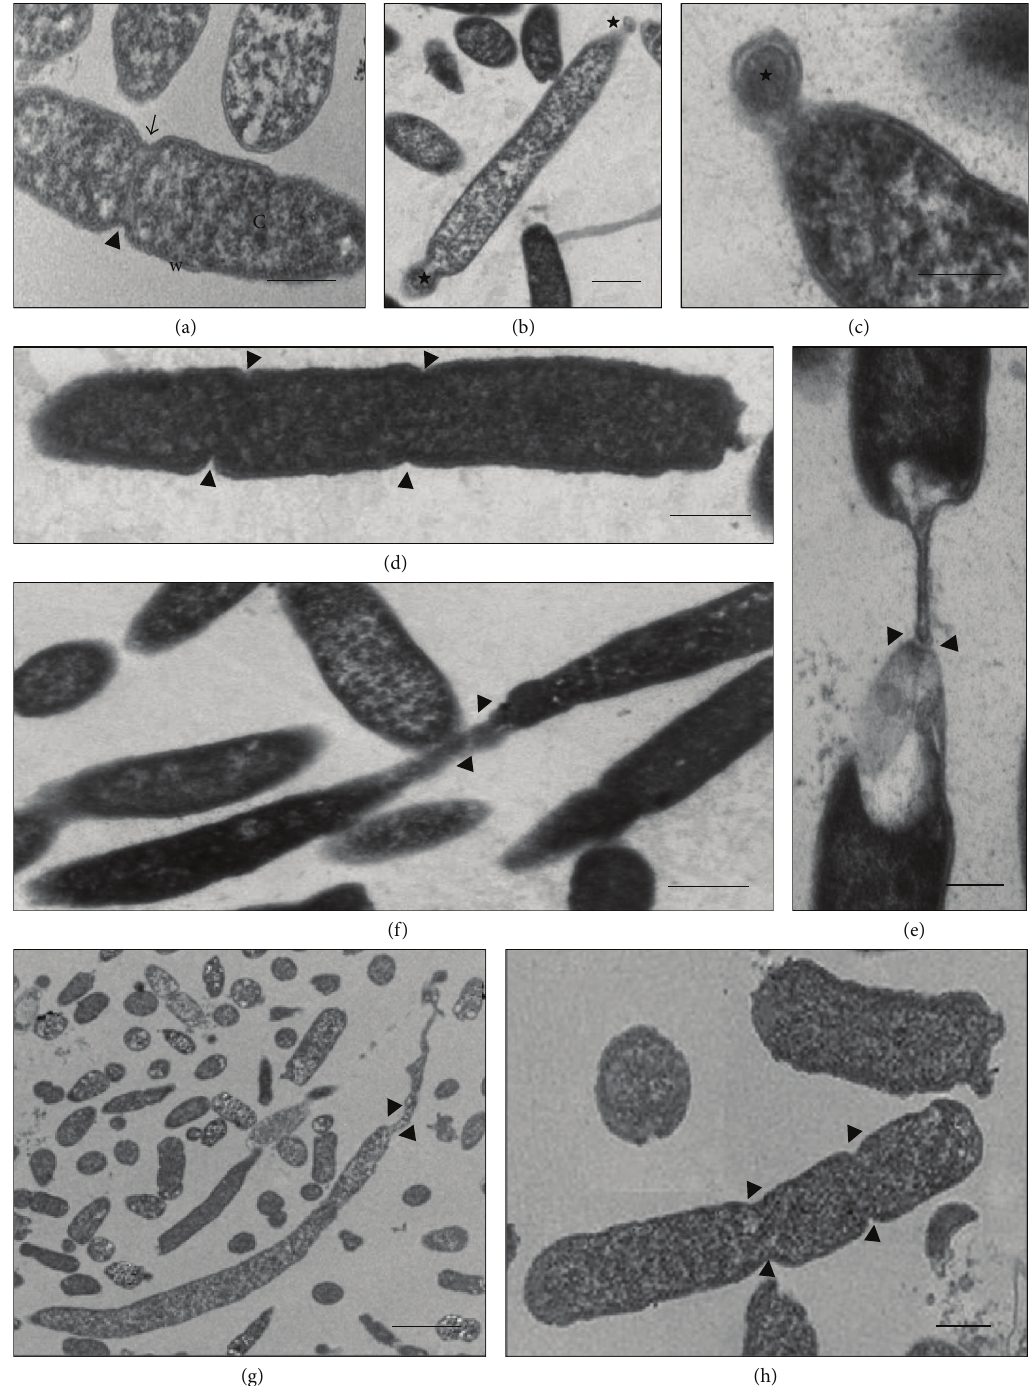
Figure 3: (a–h) Transmission electron micrographs of isolate K652 of K. pneumoniae . (a) Untreated bacterial cell—cell wall with preserved morphology (w) and cytoplasm (C) intact, besides regular septation (arrowheads). (b-c) Cell subjected to CTX (98 𝜇 gmL −1 )—presence of cells not grown and rounded (stars) at the ends of cells with normal morphology. (d–f) Cells subjected to CAZ (27 𝜇 gmL −1 )— consecutive formation of septa (arrowheads) providing elongation of bacterial morphology. Observe disorganization of membrane and cell wall with elastic aspect. (g-h) Cell subjected to IMP (16 𝜇 g mL −1 )—morphology of elongated appearance with formation of consecutive septa (arrowheads). Bars = 0.5 𝜇 m. CAZ: ceftazidime; CTX: cefotaxime; and IMP: